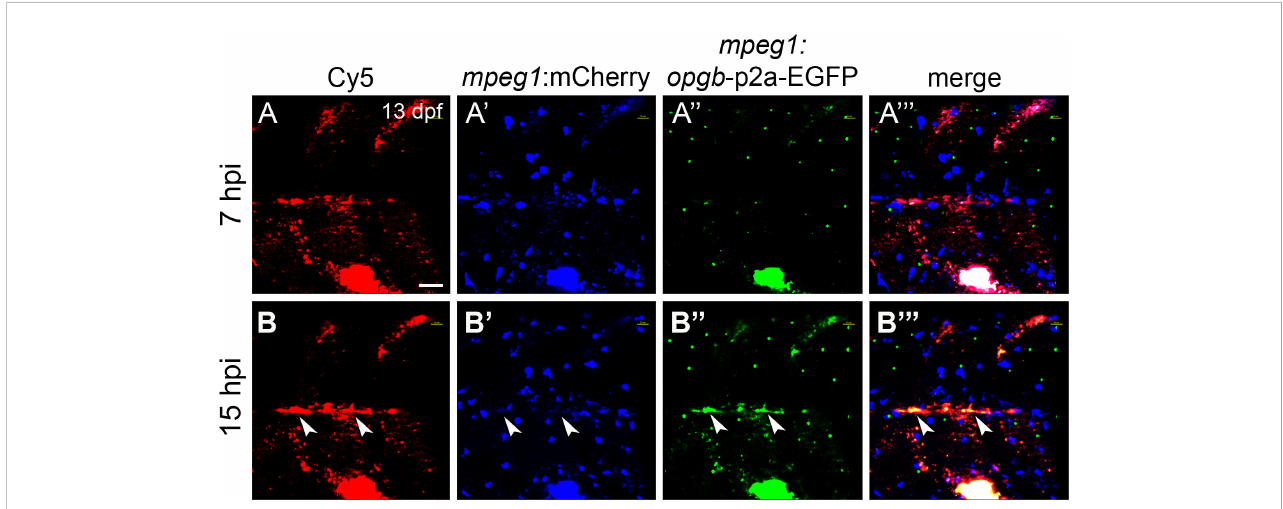
FIGURE 6 CaP nanoparticles deliver mpeg1:opgb- p2a-EGFP plasmid to macrophages. Cy5-labelled CaP nanoparticles functionalized with mpeg1:opgb- p2a-EGFP plasmid were injected into trunk muscle above the yolk extension of mpeg1 :mCherry transgenic larvae at 13 dpf. (A, A ’” ) Lateral view of trunk region at 7 hpi showing Cy5-labelled nanoparticles (A) , mpeg1 :mCherry-expressing macrophages (A ’ ), mpeg1 : opgb- p2a-EGFP expressing cells (A ” ) and a merged image (A ’” ) . Note that some macrophages internalized CaP nanoparticles but did not express opgb- p2a-EGFP at this early stage. (B, B ’” ) Same larva at 15 hpi. Note colocalization of Cy5, mpeg1 :mCherry and mpeg1:opgb- p2a-EGFP (arrowheads), suggesting that macrophages have internalized CaP nanoparticles and express opgb- p2a-EGFP. Scale bar = 40 m m. 6 out of 6 analyzed embryos showed this phenotype.